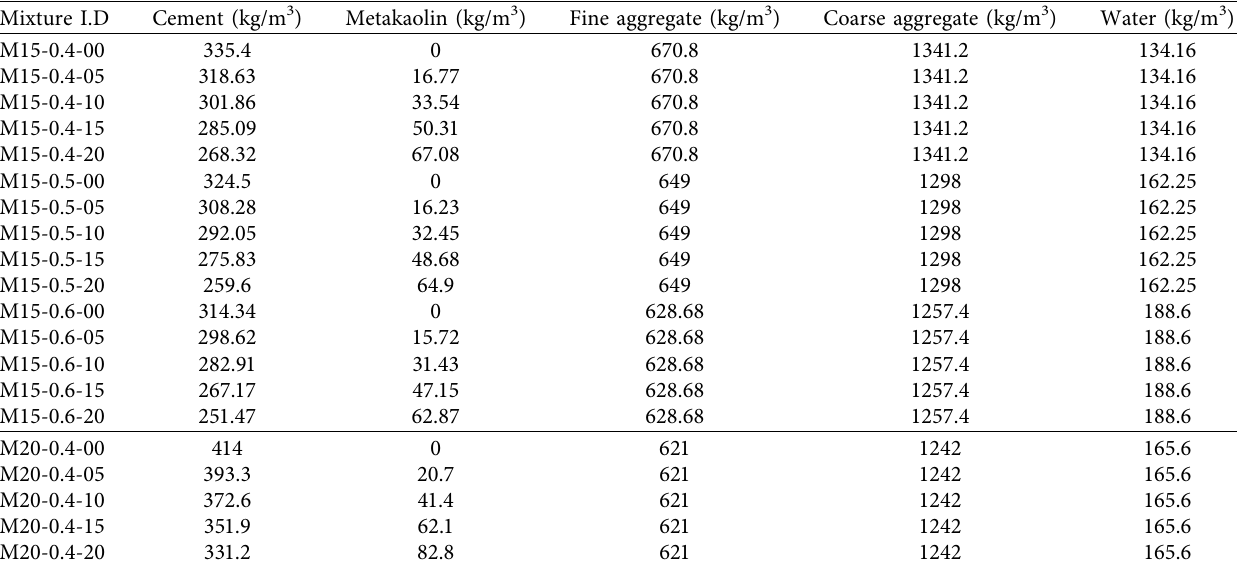
Table 2: The mixture proportion: three different water/binder ratios for each of grade M15 and M20 concrete. Mixture